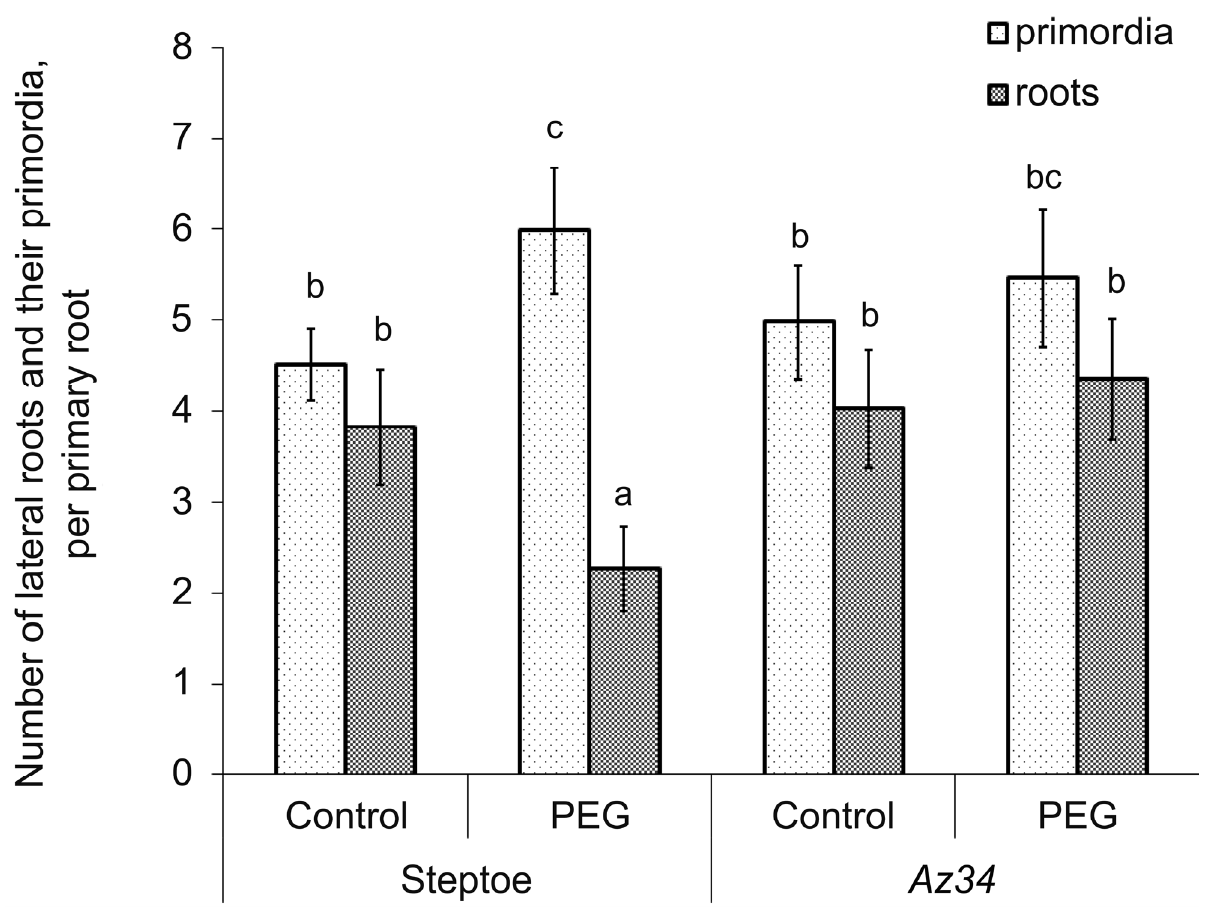
Figure 1. Number of lateral roots and their primordia in 6-day-old ABA-deficient Az34 barley plants and their parental cultivar Steptoe grown under control conditions, or exposed for 3 days to 6 % polyethylene glycol (PEG). Significant differences are marked with different letters. Values are means ± S.E. ( n = 25) ( p ≤ 0.05, t-test).